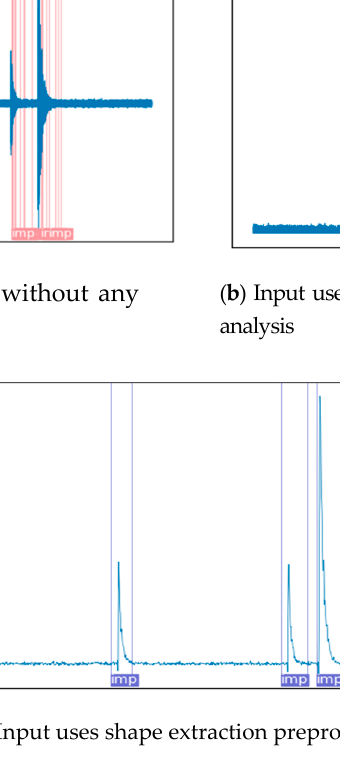
Figure 6. Performance of the DLFBR algorithm with different preprocessing: ( a ) Input with raw signal without any preprocessing; ( b ) input uses preprocessing based on envelope analysis; ( c ) and input uses the proposed shape extraction (SE) preprocessing.